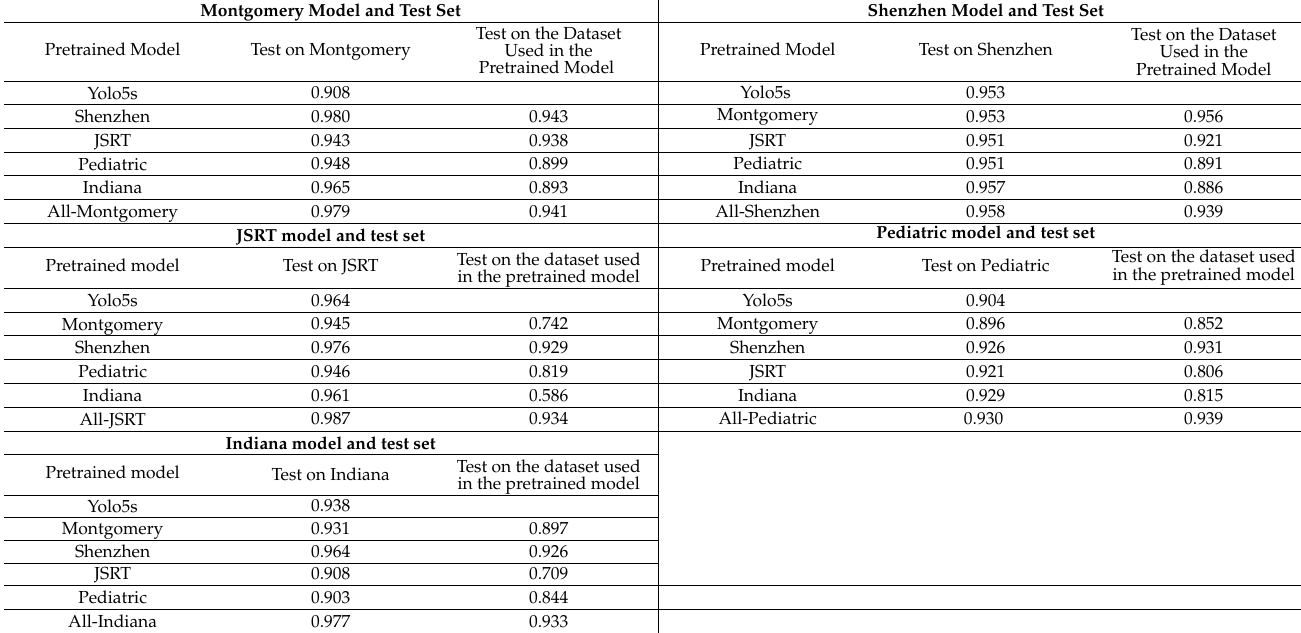
Table 4. Trained with individual dataset but initialized with weights from models trained with another